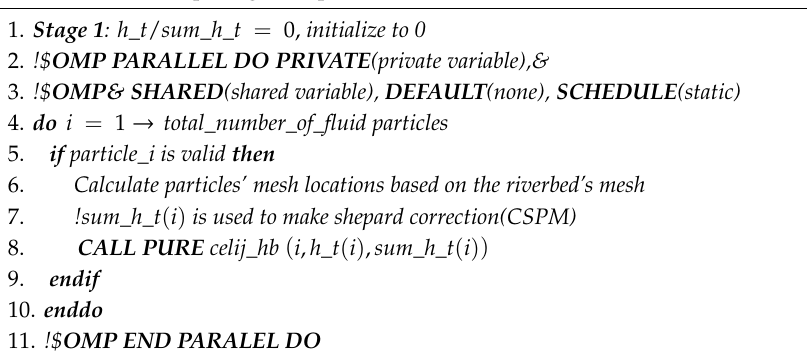
Algorithm 2. Computing fluid particle